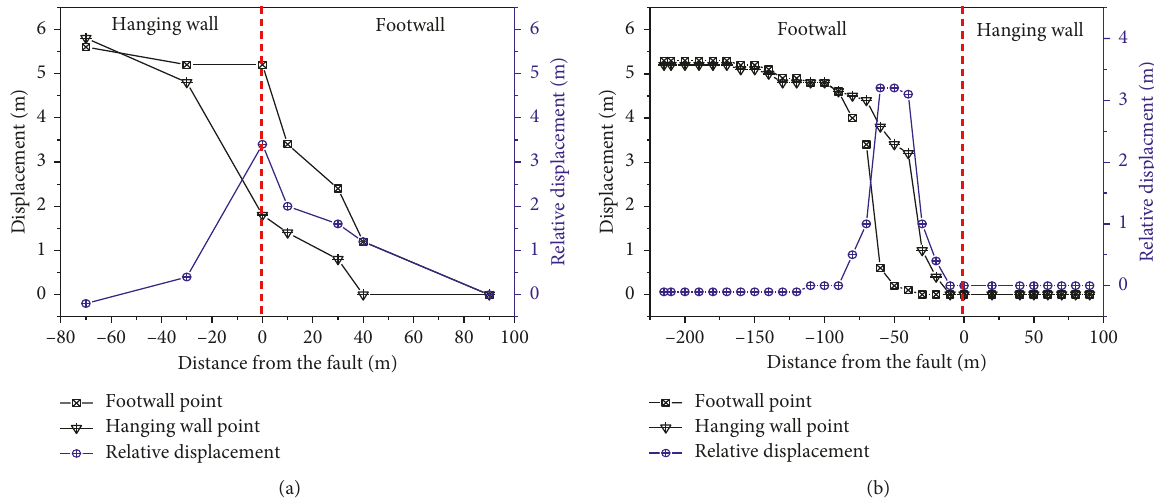
Figure 6: Variation curves of displacement and relative displacement of two fault walls. (a) Footwall mining. (b) Hanging wall mining.